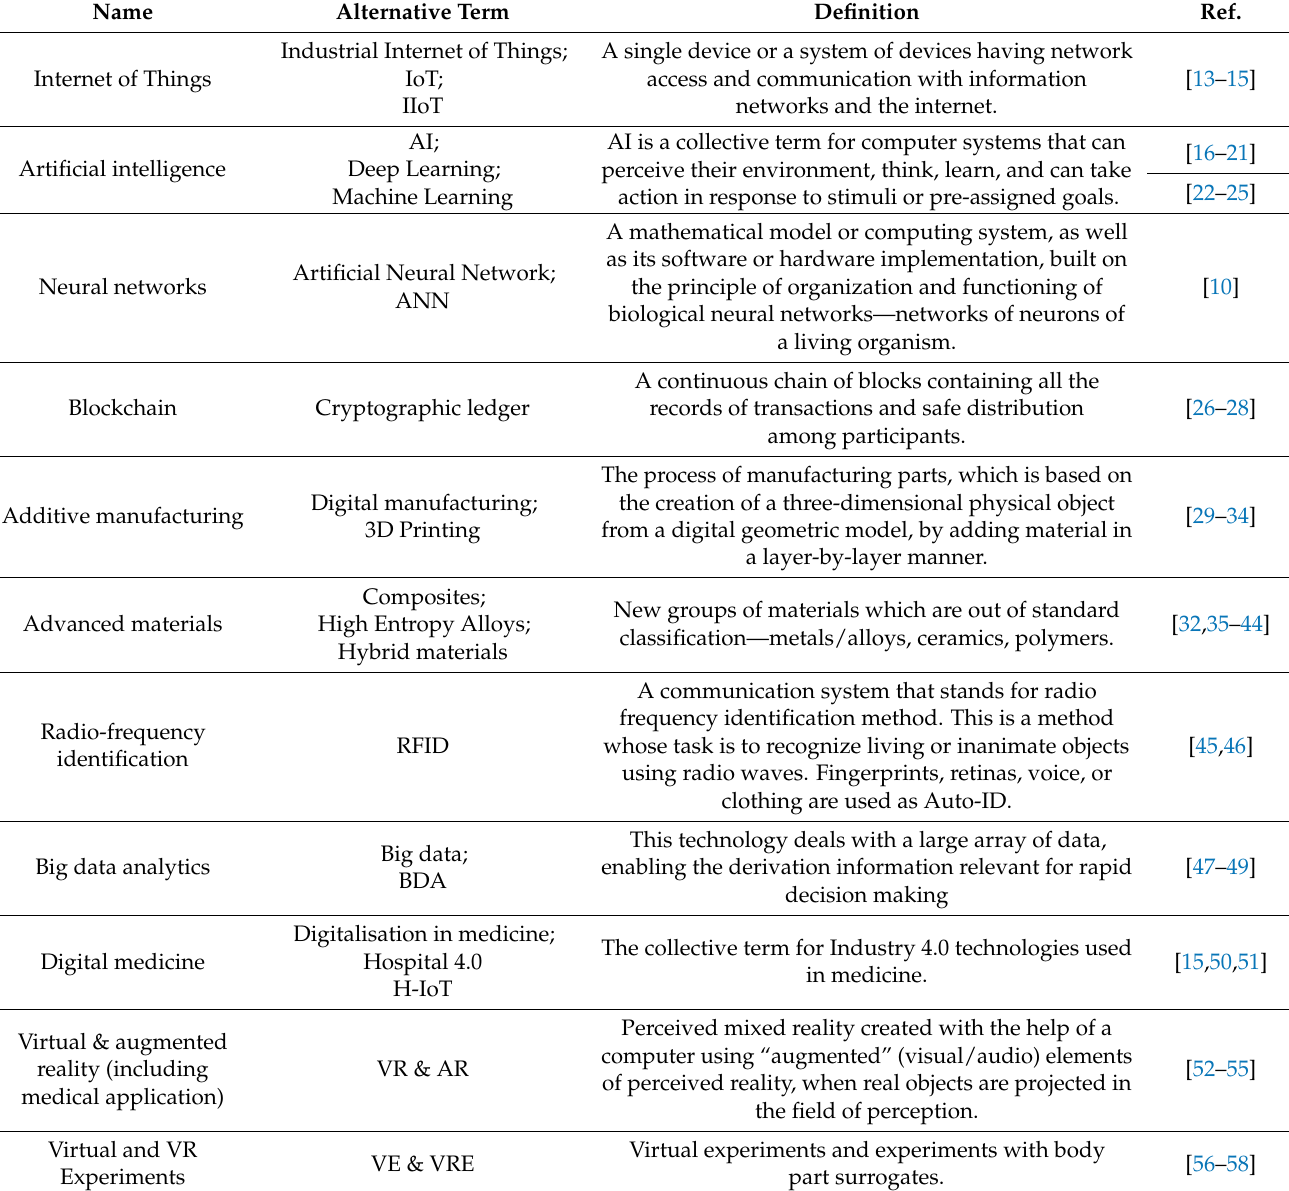
Table 1. Definitions of critical elements in an Industry 4.0